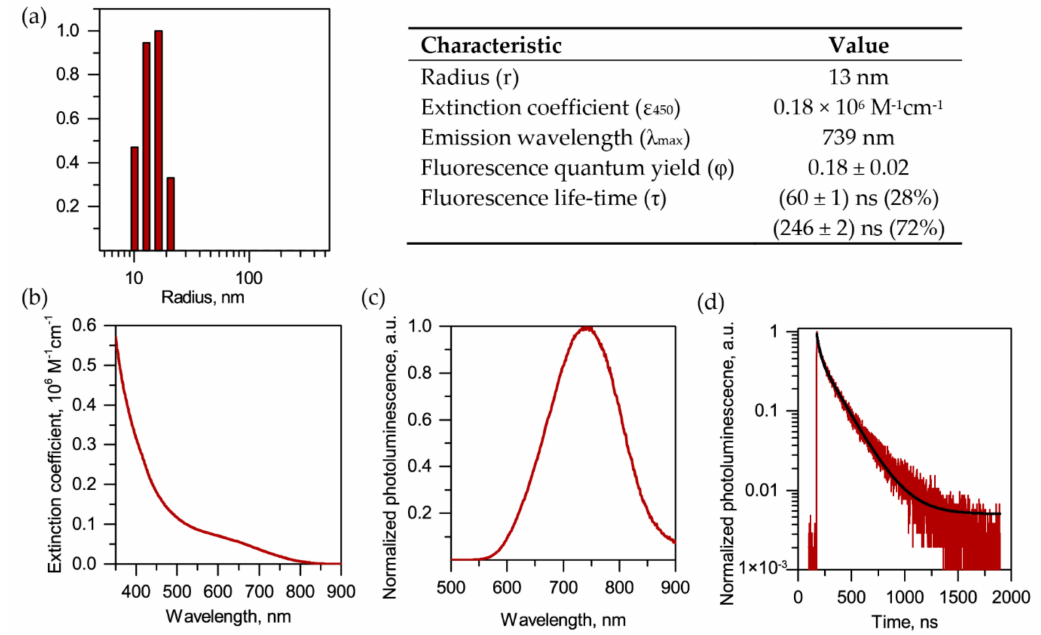
Figure 2. Characterization of QDs. ( a ) Dynamic light scattering (DLS) size distribution histograms and photophysical properties of QDs (right panel). ( b ) Absorbance and ( c ) fluorescence spectra of QDs. ( d ) Fluorescence emission decay curves of QDs. The black line corresponds to a biexponential fit, with the characteristic decay times and weights indicated in the right